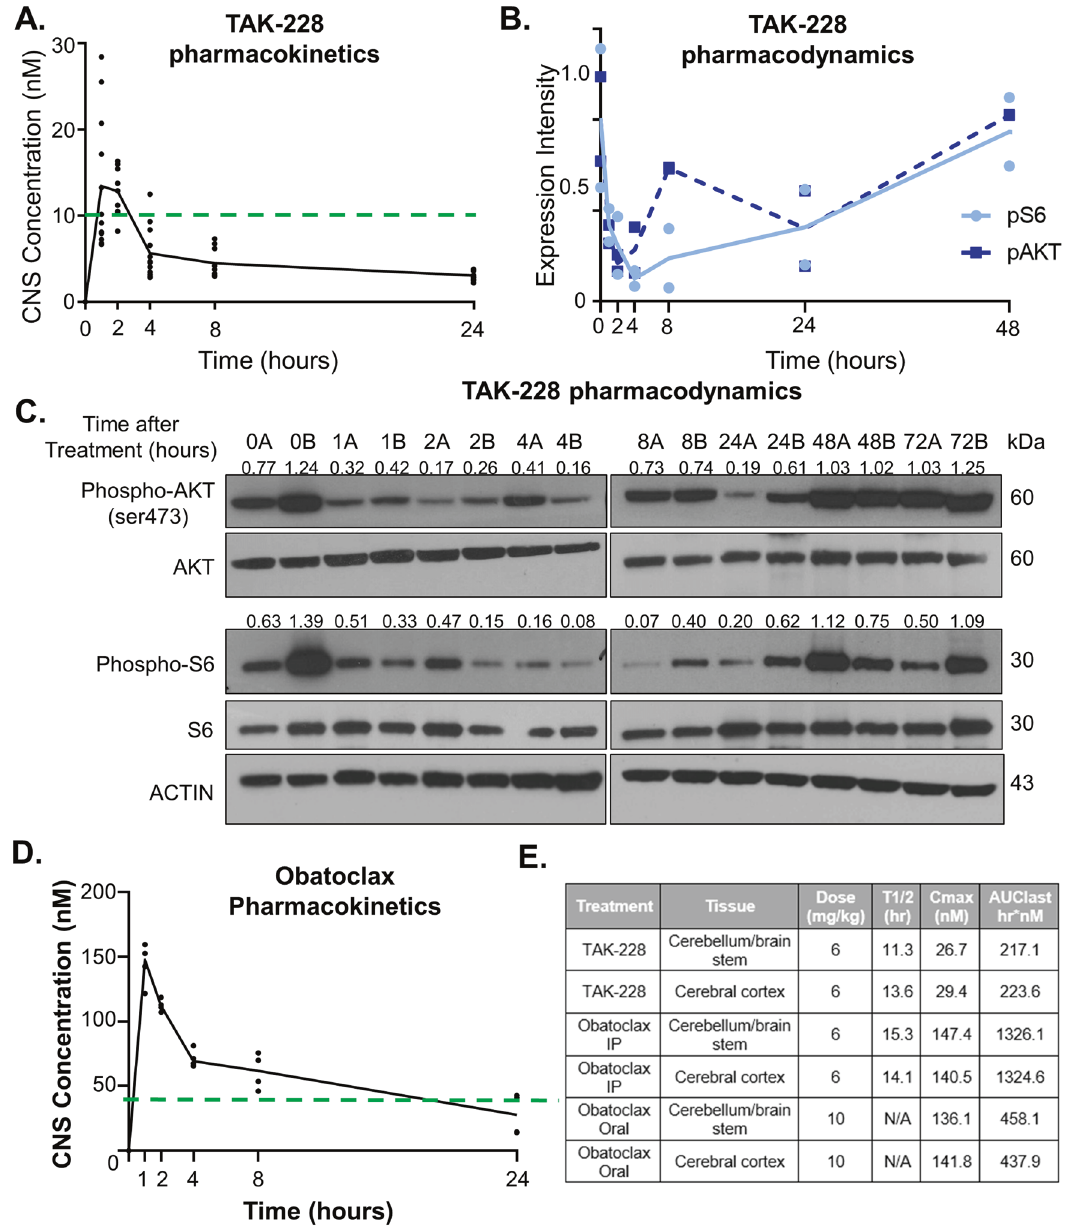
Fig. 7 TAK-228 and Obatoclax readily cross the blood – brain barrier in supratherapeutic concentrations. Pharmacokinetic and pharmacodynamics studies in mice bearing AT/RT orthotopic xenografts after treatment with a single dose of 6 mg/kg oral TAK-228, 6 mg/kg IP Obatoclax, or 10 mg/kg oral Obatoclax. A TAK-228 concentrations in mouse brains 0 – 24 h after treatment. Circles represent each individual sample with line through the median values. Dotted horizontal line represents concentrations required in vitro to inhibit mTORC1 and mTORC2 activation. B Mice bearing orthotopic xenografts of CHLA06 were treated with a single dose of 6 mg/kg oral TAK-228 and euthanized between 0 and 72 h after treatment. Graphical representation of phospho-S6 and phospho-AKT Ser473 expression normalized to total S6 or AKT, respectively, and ACTIN and the mean value in untreated control tumors. Dotted line represents mean of phospho-AKT expression values and solid line represents mean of phospho-S6 expression levels. C Western blot of extracted tumor protein. Numbers above blot represent quanti fi cation of blots normalized to ACTIN and the mean of untreated control tumors. Two samples for each hour after treatment labeled A and B. D Obatoclax concentrations in mouse brains 0 – 24 h after 6 mg/kg IP treatment. Circle represents each individual sample with line connecting the median values. Dotted horizontal line represents concentrations required to reach IC 50 in vitro. E Calculated half-life, maximum concentrations, and area under the curve in mouse